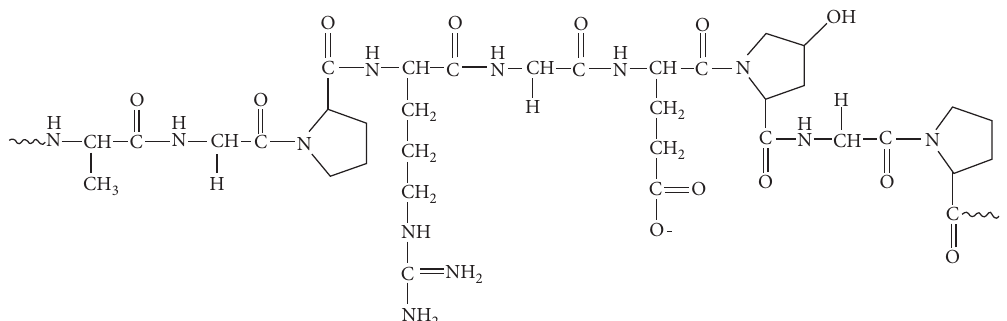
Figure 10: Chemical structure of gelatin.